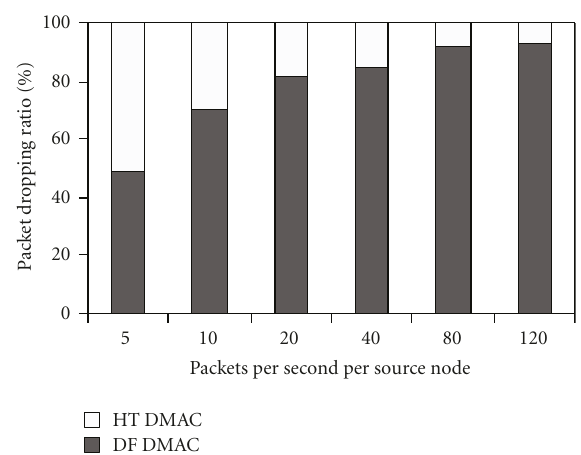
Figure 20: DMAC: deafness versus hidden terminals.